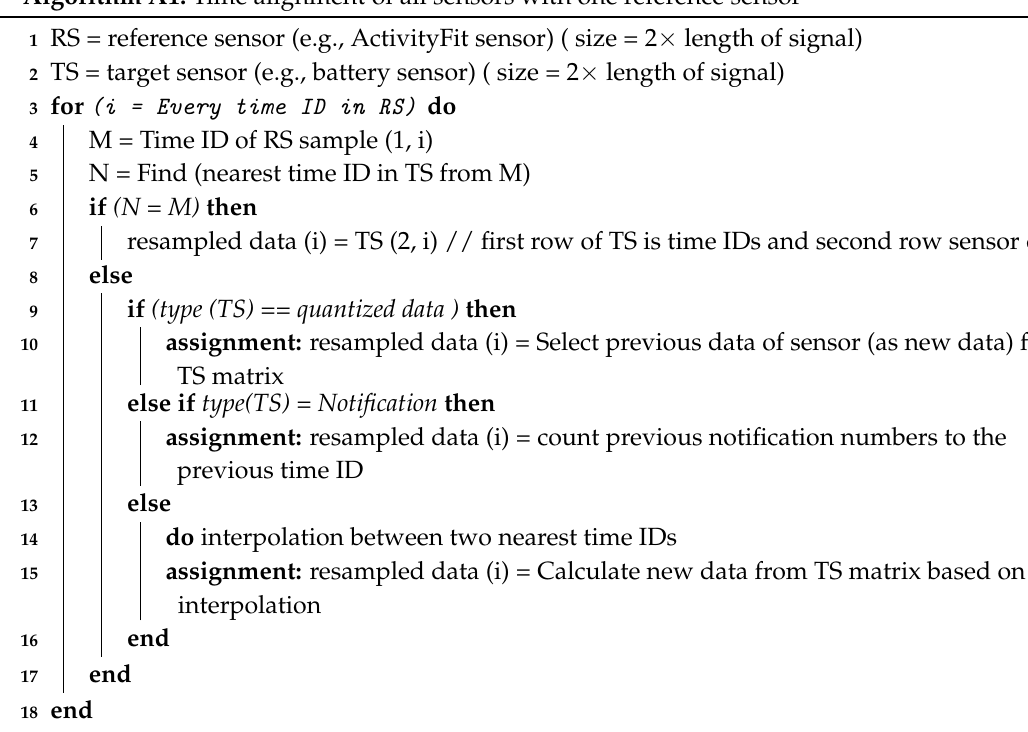
Algorithm A1: Time alignment of all sensors with one reference